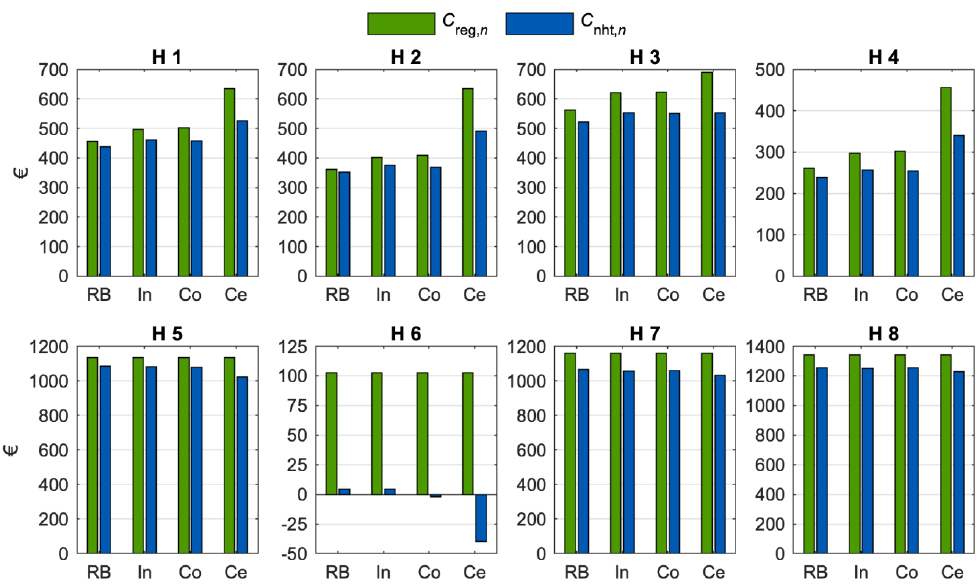
Figure 13. Individual costs when billed with regular tariffs ( 𝐶 reg,𝑛 ) and when billed with additional neighborhood tari ff s ( C nht, n ) (In: IndOpt, Co: CoordOpt, Ce: CentralOpt, H: neighborhood tariffs ( 𝐶 nht,𝑛 ) (In: IndOpt, Co: CoordOpt, Ce: CentralOpt, H: Household).